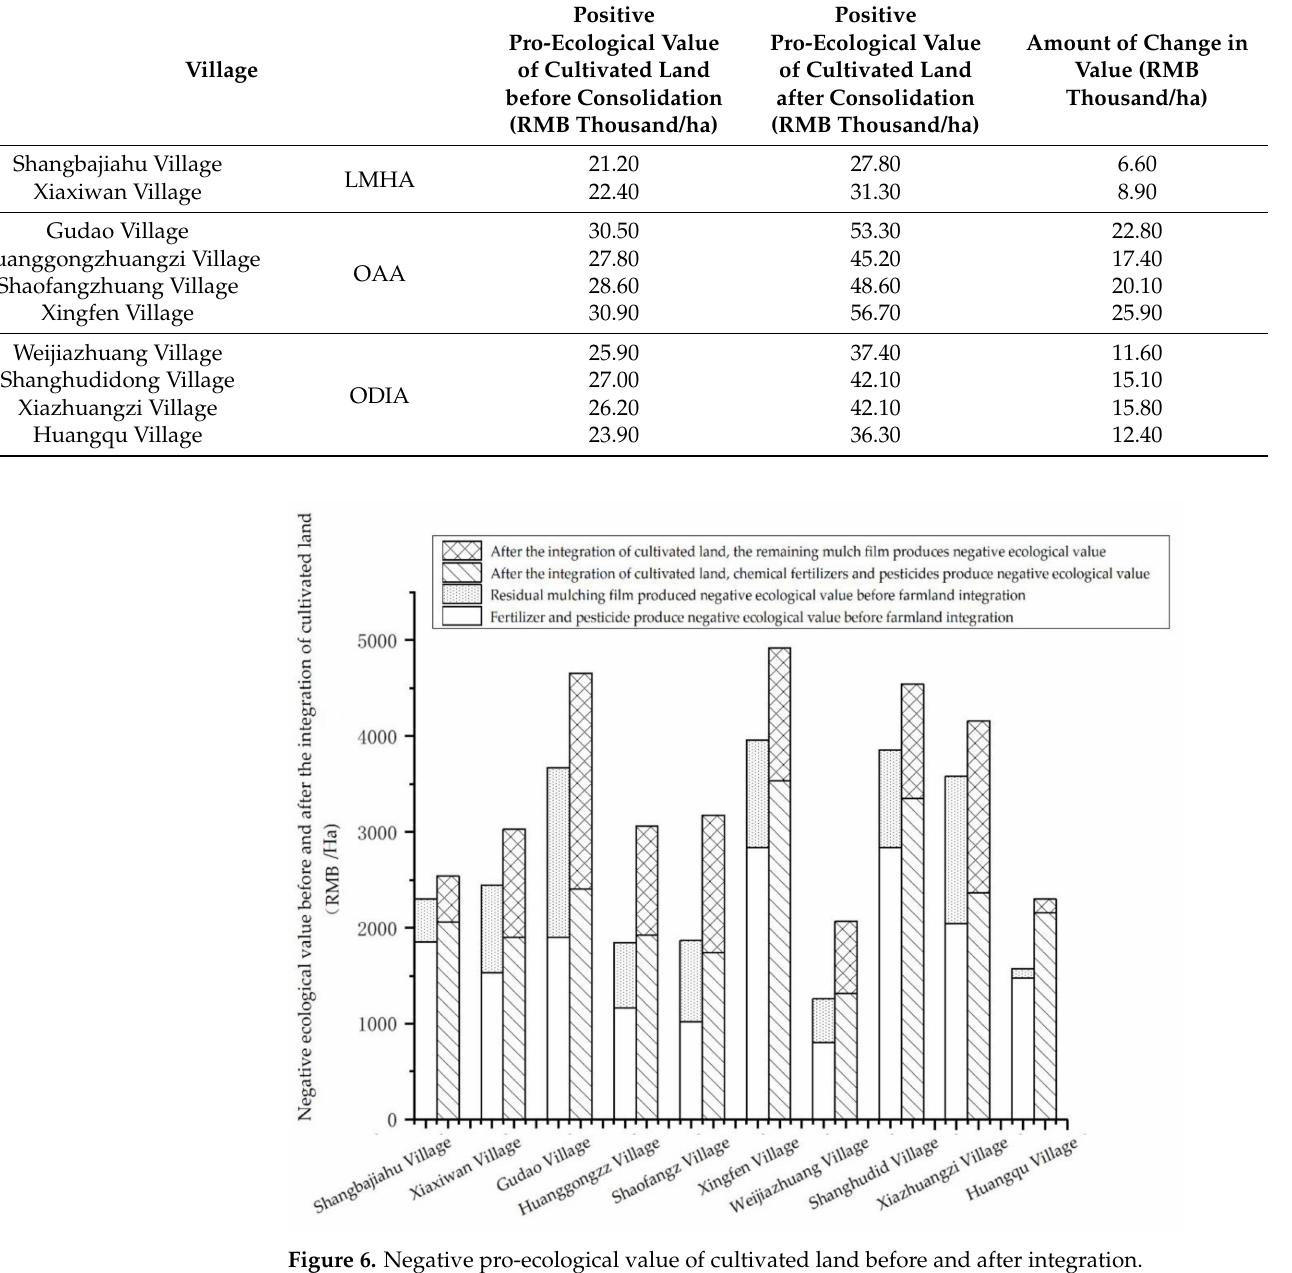
Table 4. Total positive pro-ecological value of cultivated land before and after consolidation and the amount of change. Positive Village before Consolidation after Consolidation